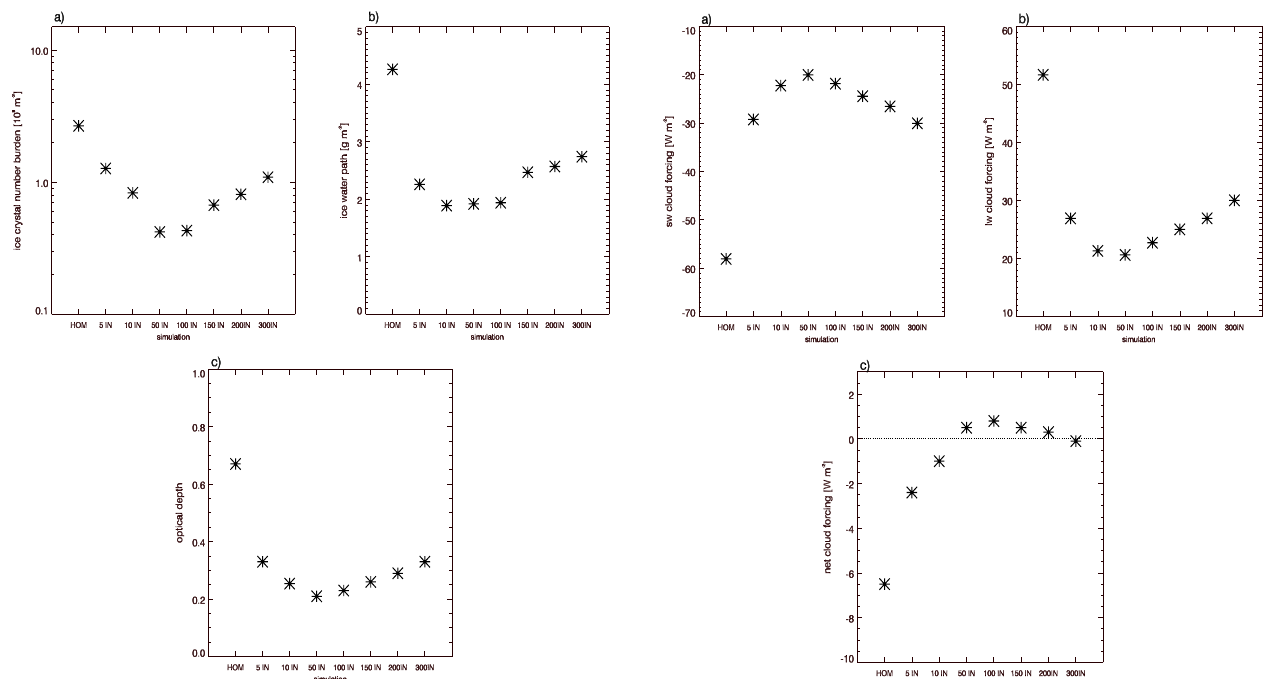
Figure A1. Averaged ice crystal number burden (a) , ice water path (b) and optical depth (c) for the simulations HOM, 5 IN, 10 IN, 50 IN, 100 IN, 150 IN, 200 IN and 300 IN for the refer- ence temperature profile for the simulation where the IN freeze at RHi het = 130%. For the calculation of the mean, only values where τ > 0 . 03 are considered.